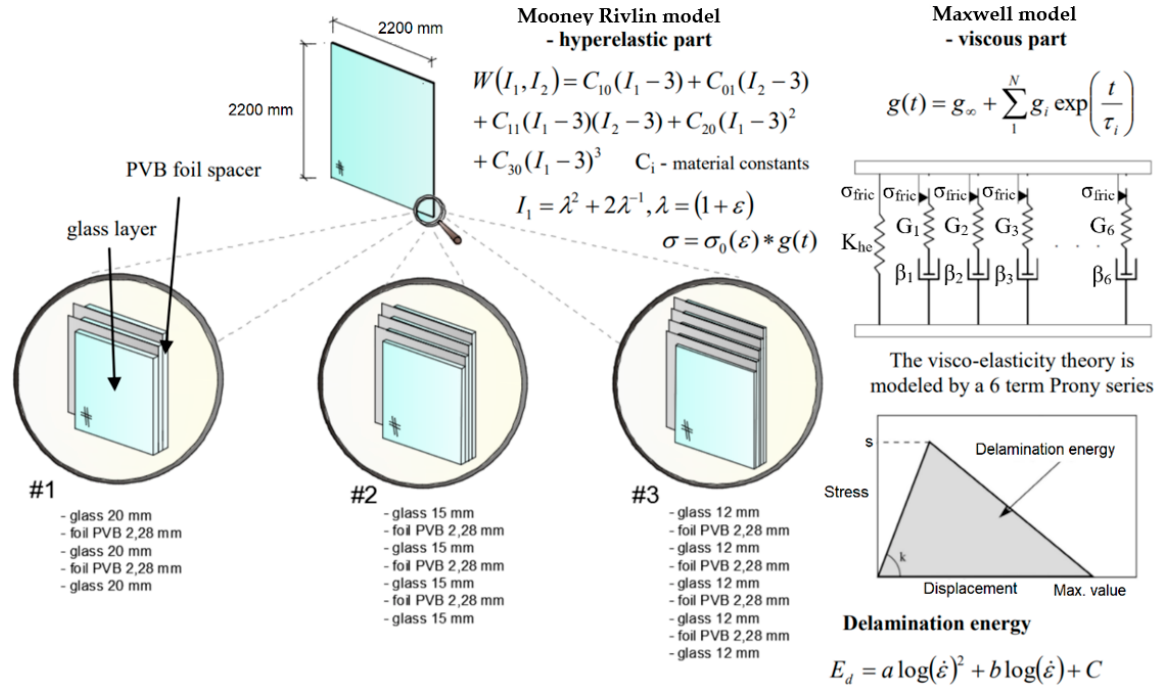
Figure 9. The mechanical model of the hyper viscous-elastic PVB material.